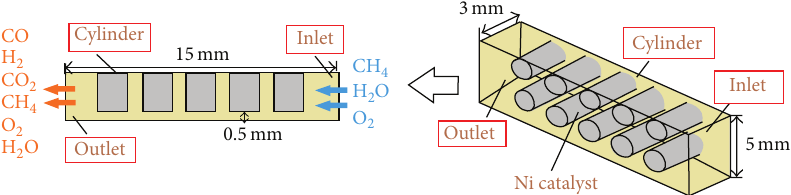
Figure 1: The schematic drawing of the microchamber reactor.